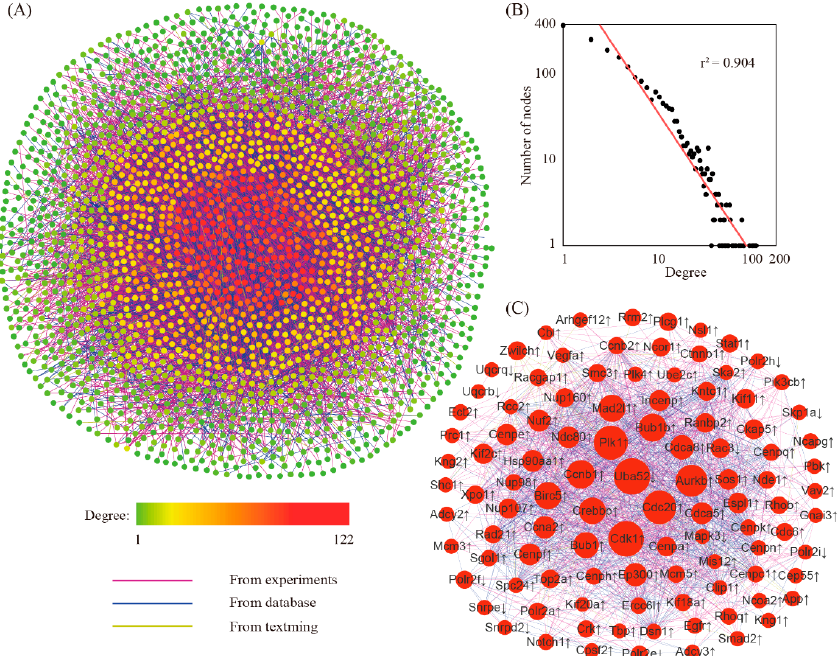
Figure 3. The gene network for differentially expressed genes. ( A ) The structure of the gene network. ( B ) Degree distribution analysis. ( C ) The sub-network focusing on hub genes. Genes with a degree value exceeding mean + 2 × SD were defined as hub genes. ↓ , down-regulated genes; ↑ , up-regulated